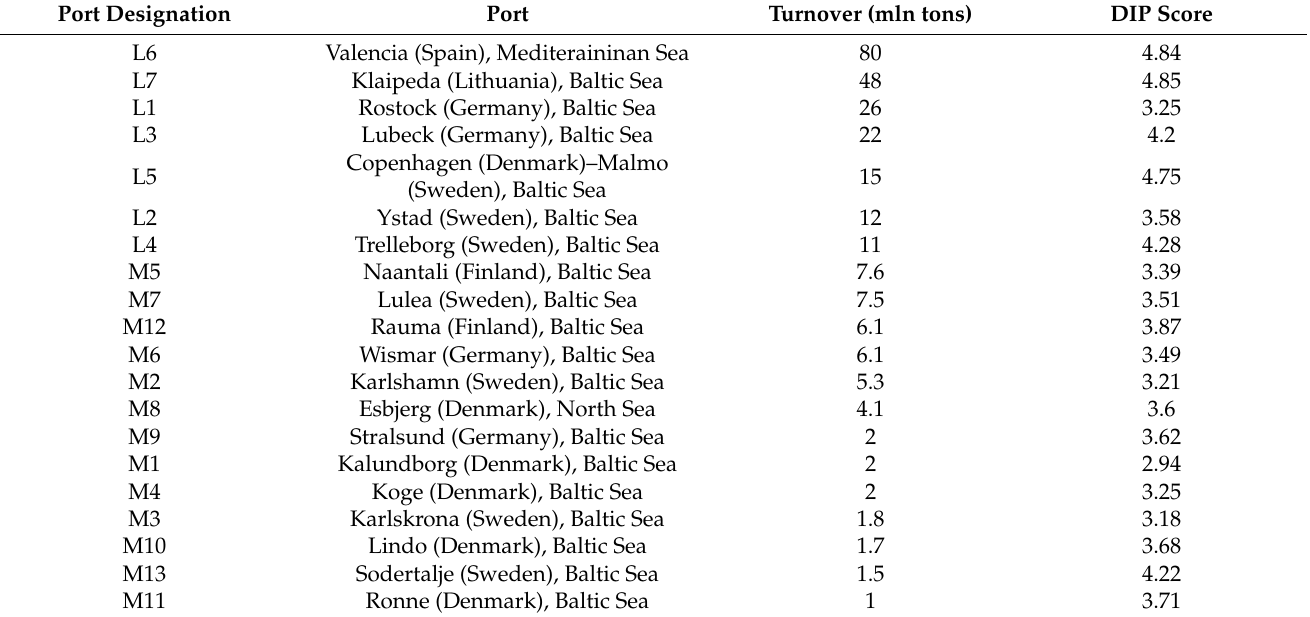
Table 7. Compilation of analysed ports’ turnover and calculated DIP